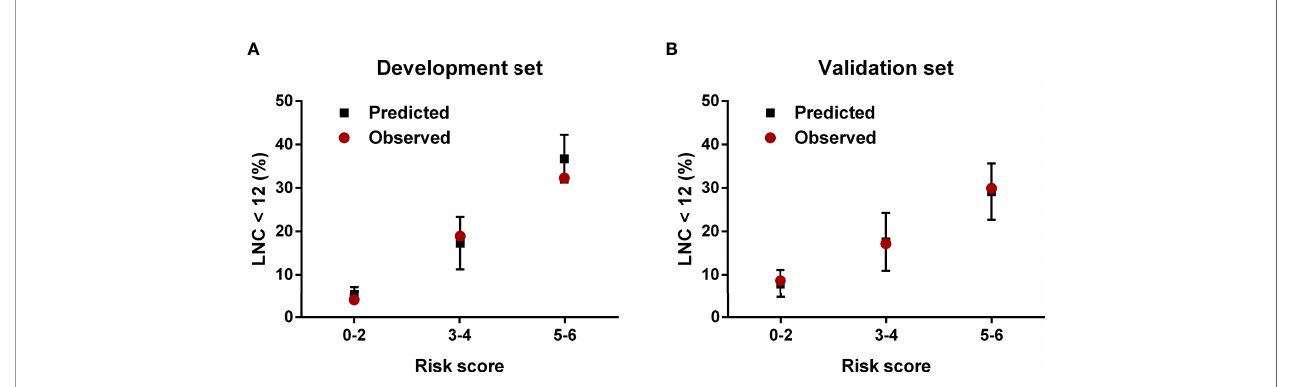
FIGURE 5 | The predicted and observed rates of LNC < 12 in the (A) development set and (B)